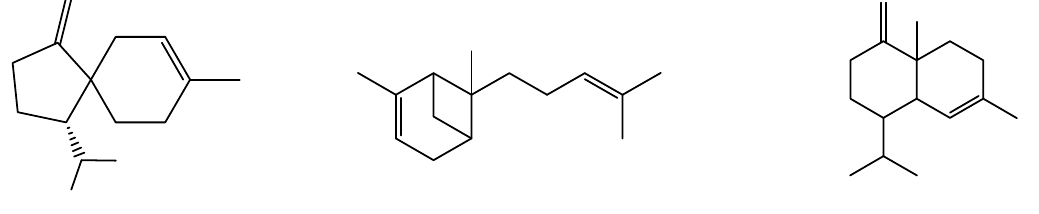
Figure 3. The major organic volatiles of essential oils from Pimpinella lutea (Desf.). growing in three different environmental conditions (North and South Bizerta and Tabarka) of Tunisia.